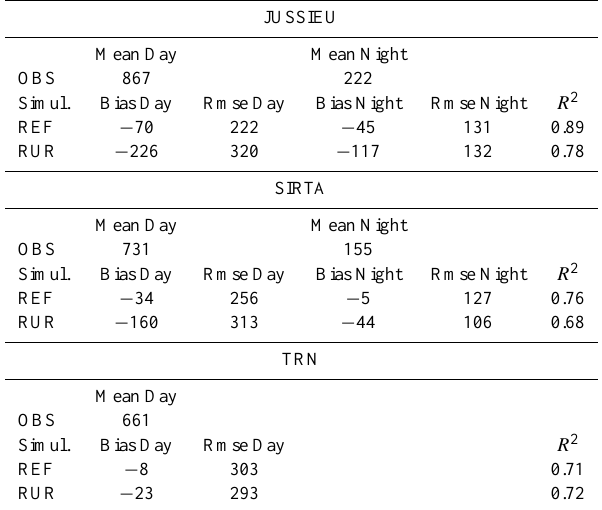
Table 4. Mean observed, bias, rmse and correlation coefficient ( R 2 ) of the BLH for the REF and RUR simulations. Nighttime is consid- ered from 19:00UTC to